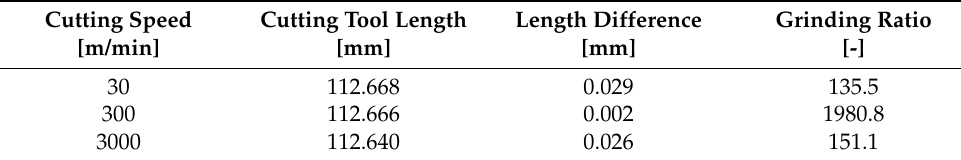
Table 6. Recorded values of tool length after machining of